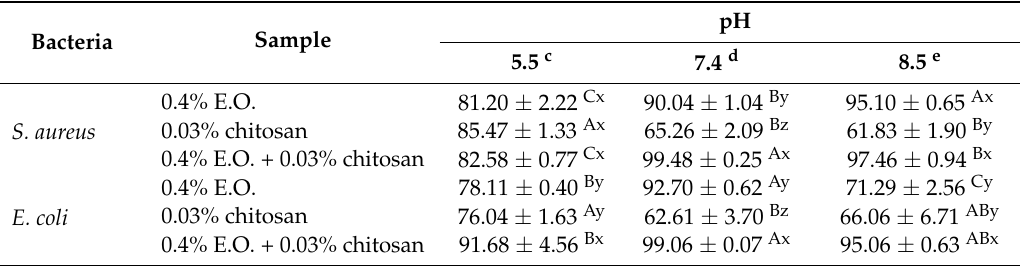
Table 6. Effects of adding emulsified pomelo peel oil, chitosan, and E.O.-chitosan in broths of different pH values on the inhibitory percentage (%) of S. aureus and E. coli a,b